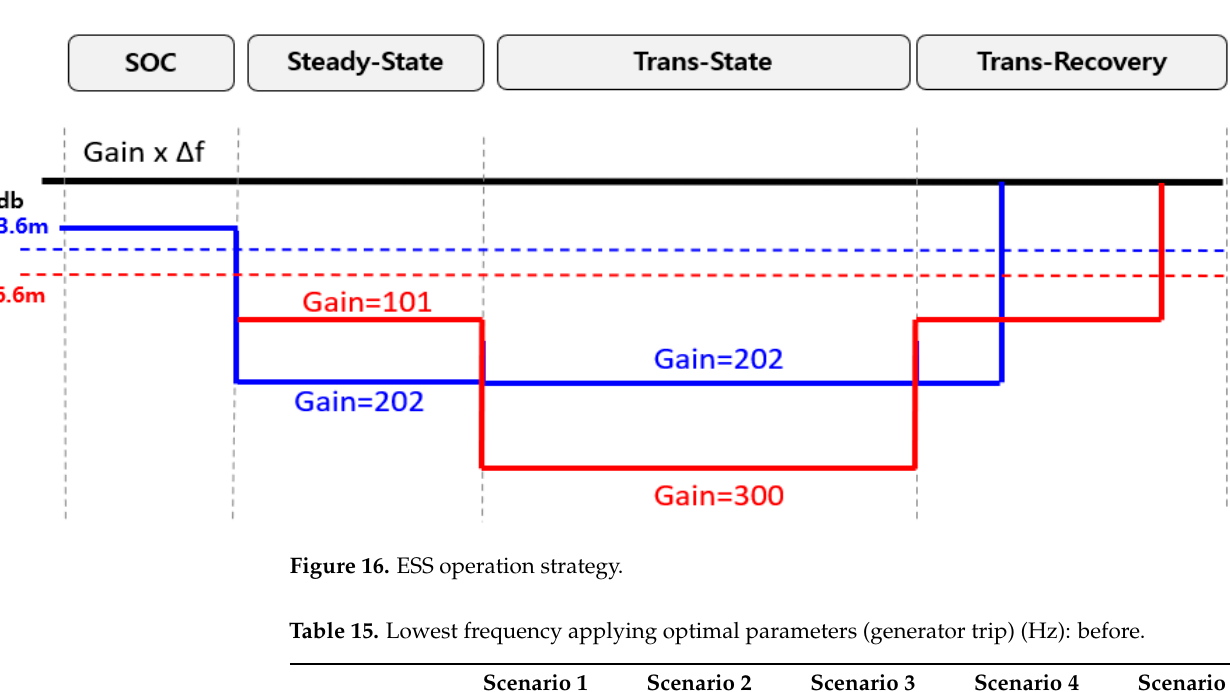
Figure 15. Frequency Response by ESS Parameter (RoCoF Control).